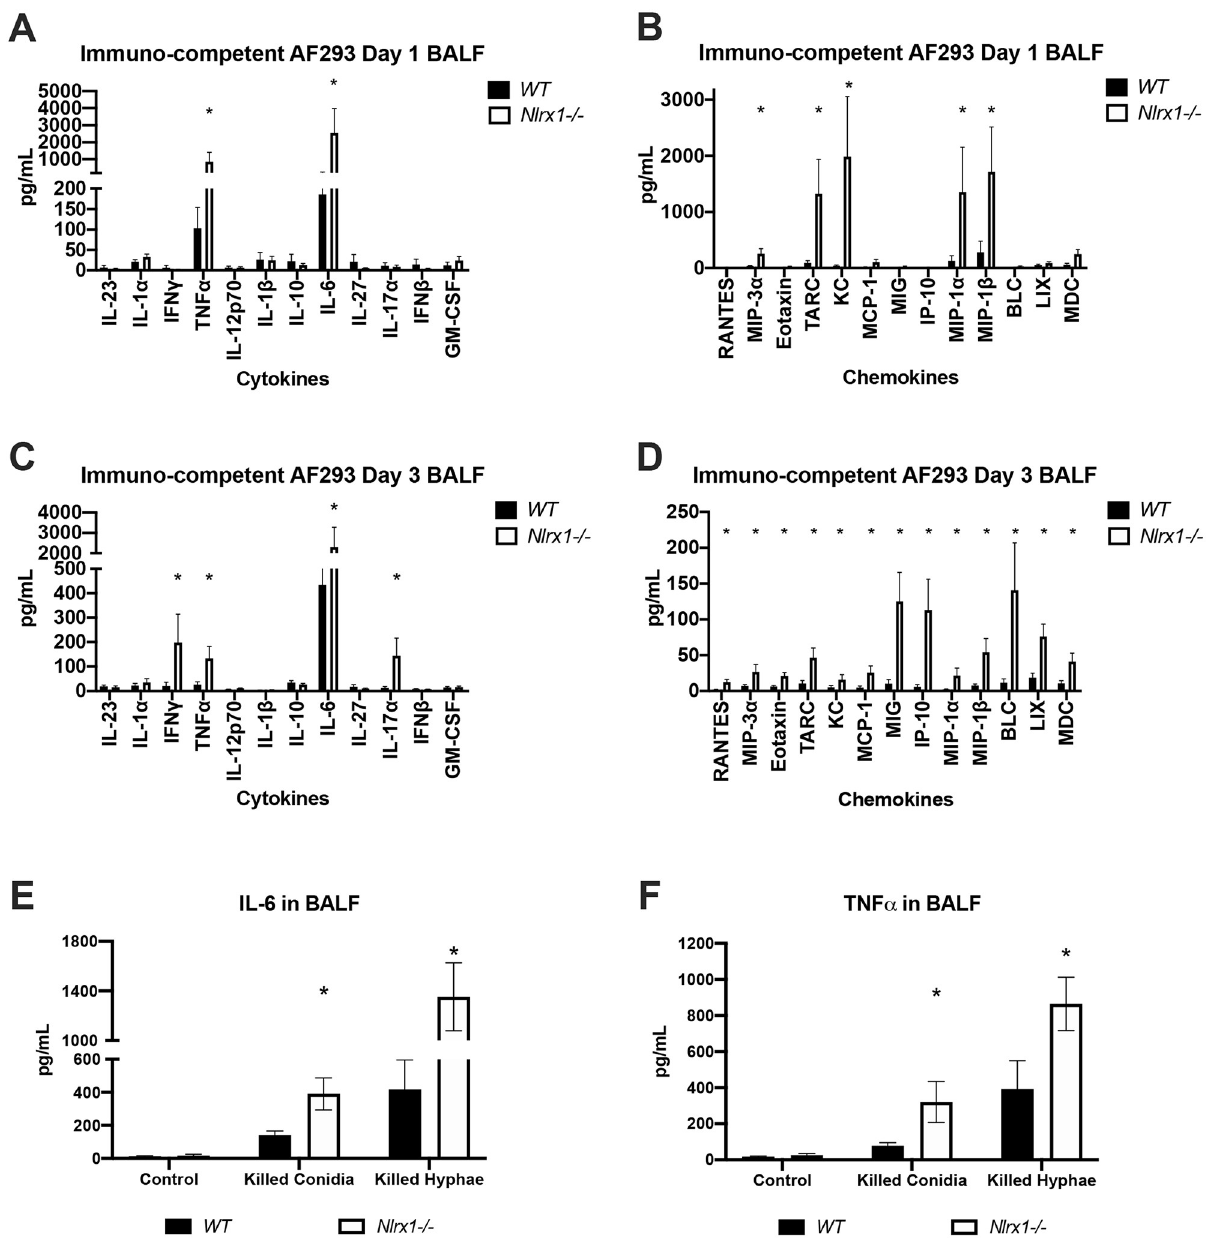
Fig 3. Characterization of secreted cytokines/chemokines and recruited leukocyte populations on day 1 and 3 post inoculation with AF293. Freshly harvested conidia from the AF293 isolate were delivered via aerosolization (12 mL, 1 X 10 9 conidia/mL) to immuno-competent wild type and Nlrx1-/- mice. Bronchoalveolar lavage fluid (BALF) was extracted from mice on day 1 and 3 post inoculation. Concentration of (AC) cytokines (IL-23, IL-1 α , IFN γ , TNF α , IL-12p70, IL-1 β , IL-10, IL-6, IL-27, IL-17 α , IFN- β , GM-CSF) and (BD) chemokines (RANTES (CCL5), MIP-3 α (CCL20), Eotaxin (CCL1), TARC (CCL17), KC (CXCL1), MCP-1 (CCL2), MIG (CXCL9), IP-10 (CXCL10), MIP-1 α (CCL3), MIP-1 β (CCL4), BLC (CXCL13), LIX (CXCL5), MDC (CCL22)) in BALF on day 1 and 3 post inoculation was determined by flow cytometry bead based array. Measurement of (E) IL-6 and (F) TNF α in BALF 24 hours post challenge with killed conidia and hyphae and control PBS. (EF) Substrates delivered via non-invasive tracheal instillation. Asterisk denotes statistical significance, P < 0.05 Mann-Whitney U test. Error bars indicate standard deviation. N = 8–10 per experimental